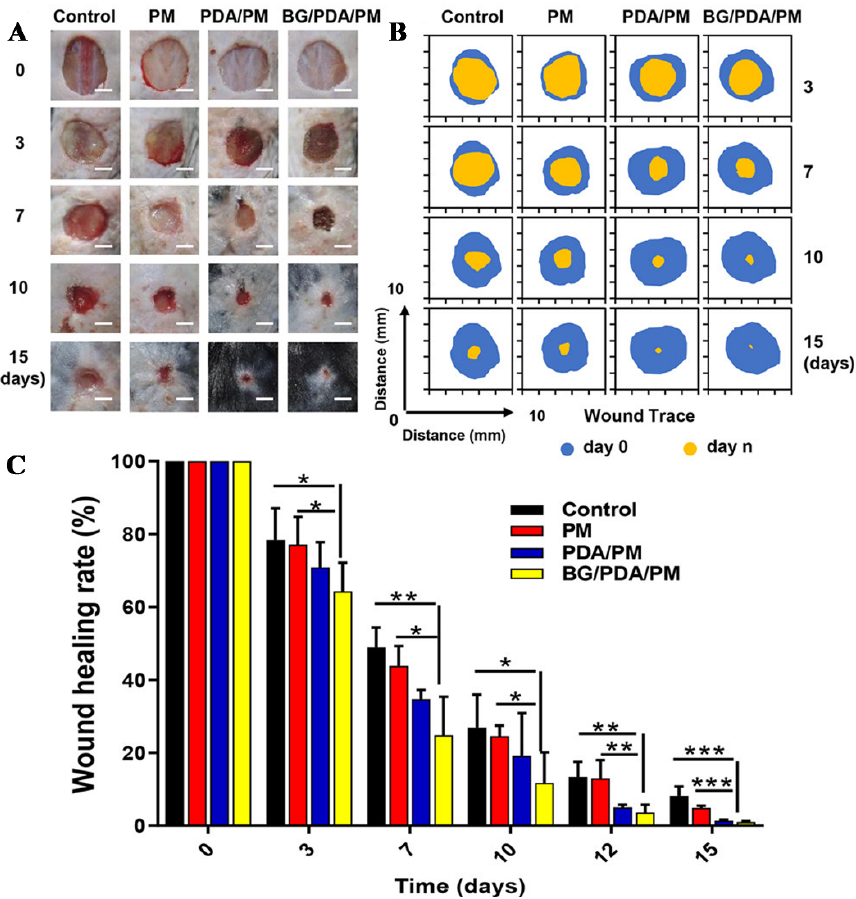
Figure 5. ( A ) Diabetic mice wound photos, ( B ) Trace of the wound area, ( C ) Wound healing rate after treatment in Ctrl, PM, PDA/PM, and BGs/PDA/PM groups at 0, 3, 7, 10, and 15 d. Data were presented as means ± standard error. Differences were considered significant when p < 0.05 (*), p < 0.01 (**), or p < 0.001 (***). Reproduced with permission from [75], ACS, 2020.